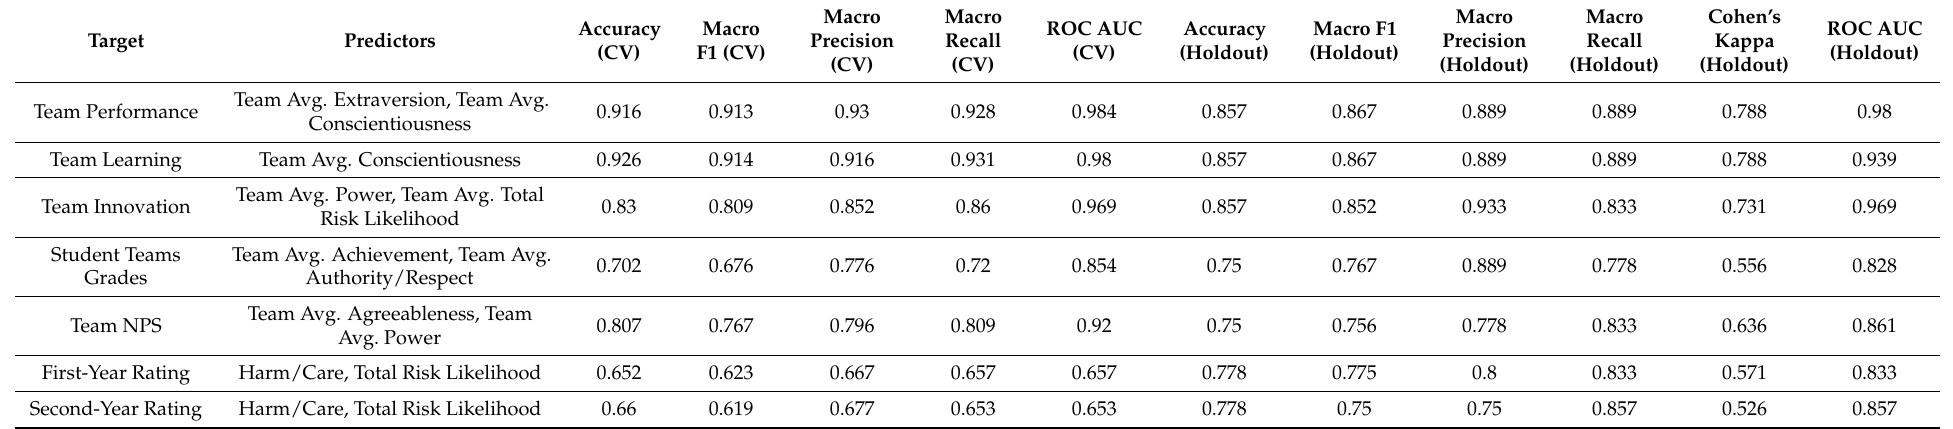
Table 5. Prediction Models for Job